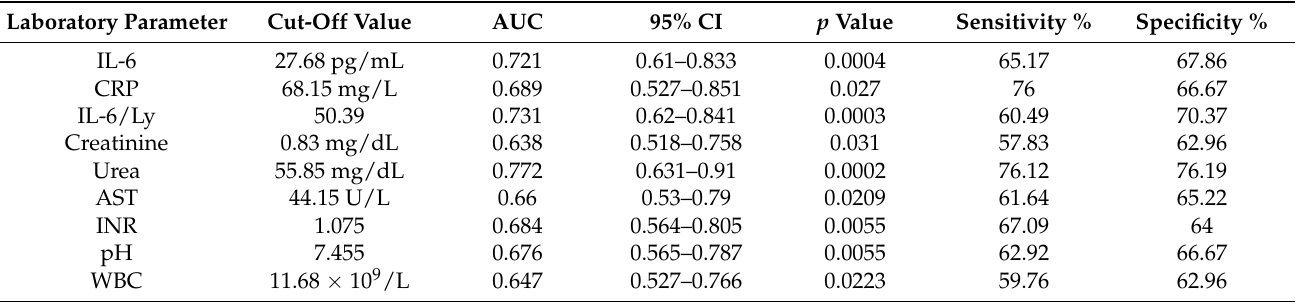
Table 3. Receiver Operating Characteristic (ROC) analysis for statistically significant biomarkers in critically ill COVID-19 patients.